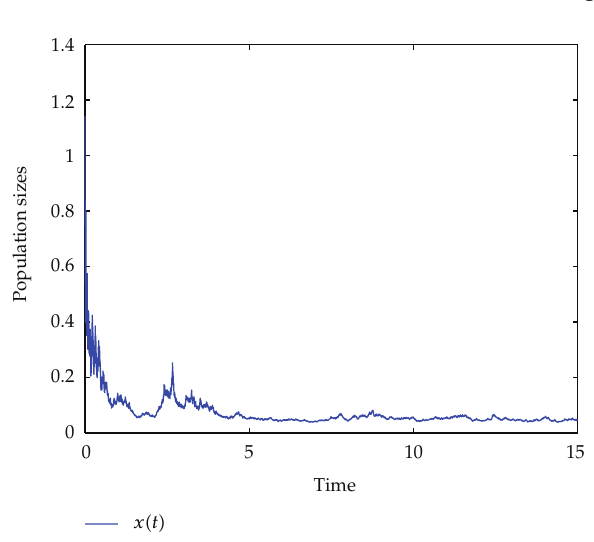
Figure 3: Stochastically weakly persistent, step size Δ t (cid:5) 0 . 001 and x (cid:3) 0 (cid:4) (cid:5) 1 .